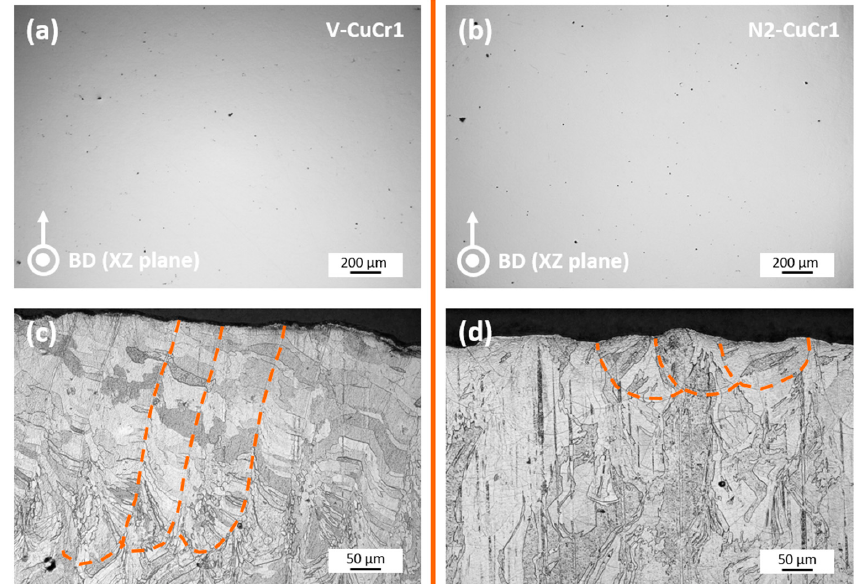
Figure 3. Build direction (XZ plane) cross-sectional surfaces for the ( a ) V-CuCr1 and ( b ) N2-CuCr1 specimens; ( c , d ) are etched sections of V-CuCr1 and N2-CuCr1, respectively, which include the top layers of the samples to highlight the general melt pool shape (orange dashed curves).